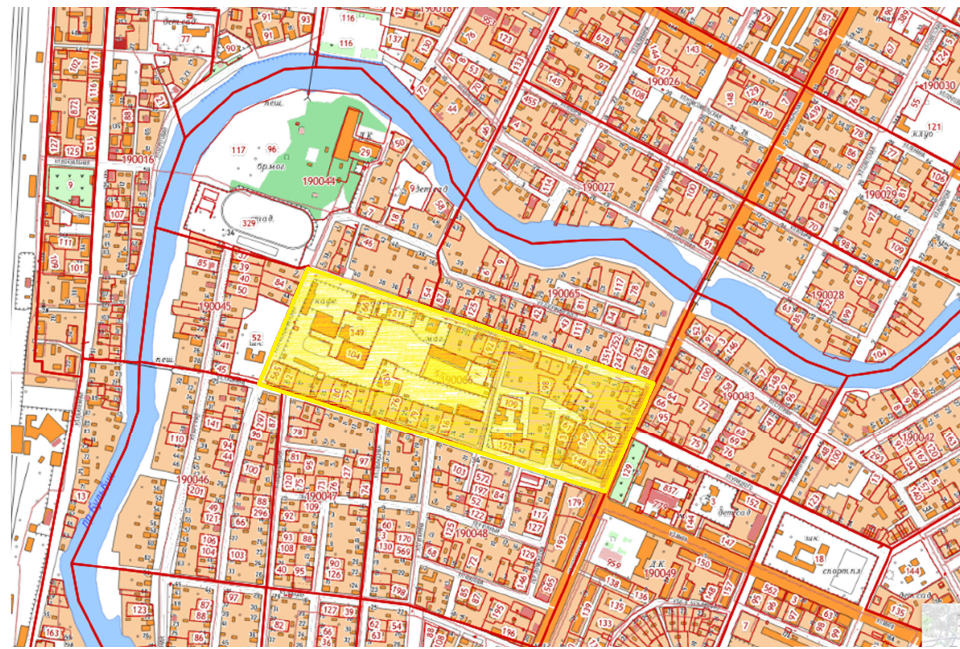
Figure 3. The study area (highlighted in yellow) is on a fragment of the public cadastral map of the city of Pallasovka, Volgograd Region, Russia. Table 3. Description of the object of study.